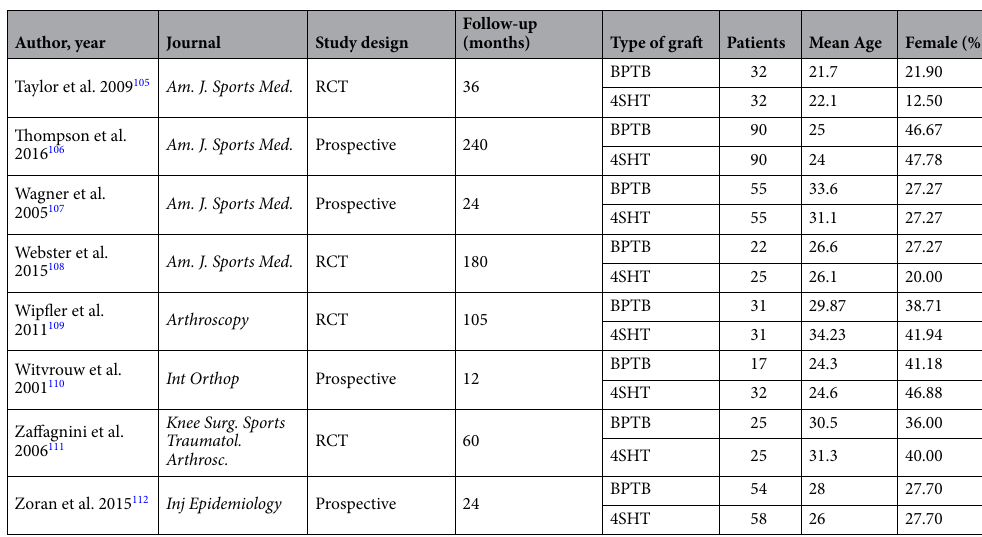
Table 1. Generalities and patient baselines from the included studies.